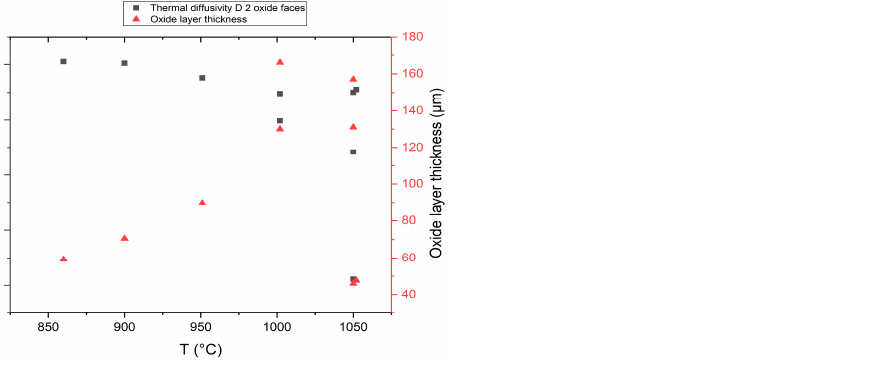
Figure 7. The influence of temperature on the thickness of the corrosion layers and on the thermal diffusivity . In order to establish the effect of the presence of corrosion layers, we determined the thermal diffusivity of the samples without the corrosion layer, with both sides polished to metallic luster (Figure 8). The values of the thermal diffusivity determined after the complete removal of the corrosion layer on both sides are higher than those corresponding to the samples with oxide layers, but they decrease when the treatment temperature increases, which shows the influence of microstructural transformations.